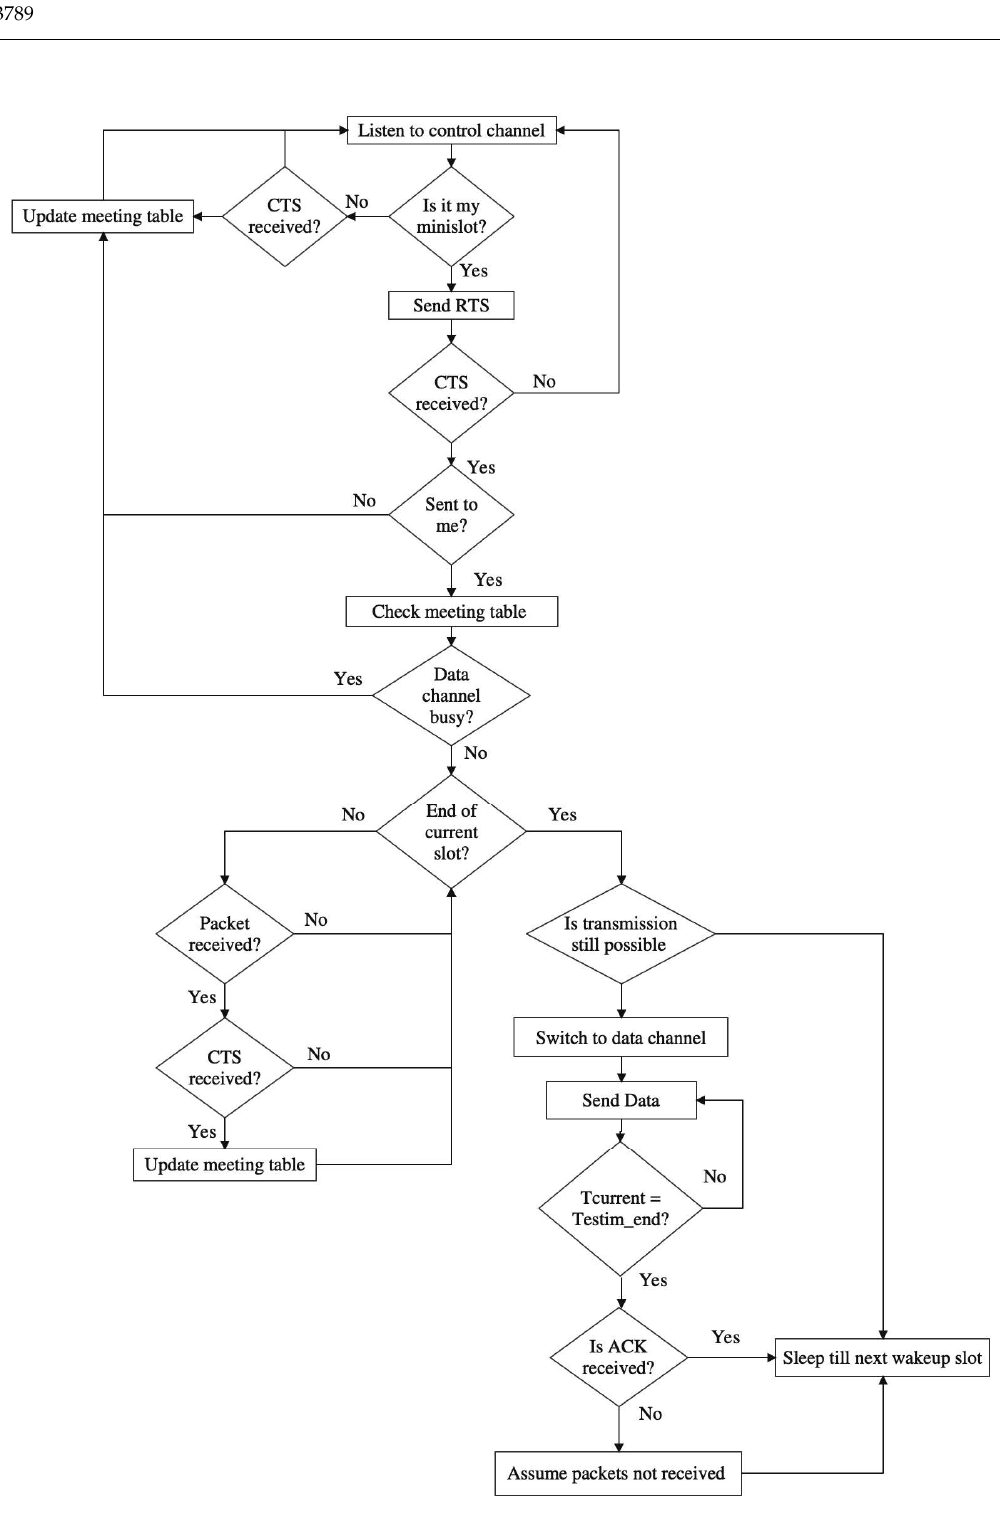
Figure 10. Sender behavior.